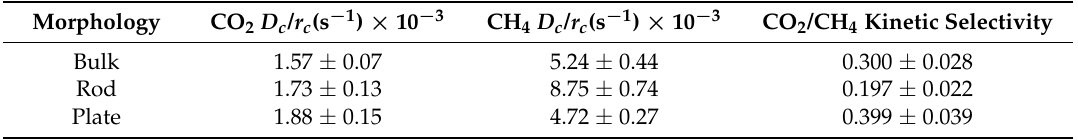
Table 4. Diffusion time constants from fitting Equation (2) to kinetic adsorption data of CO 2 and CH 4 and kinetic selectivity for varied morphologies. Individual trial data can be found in supplemental materials (Table S3).